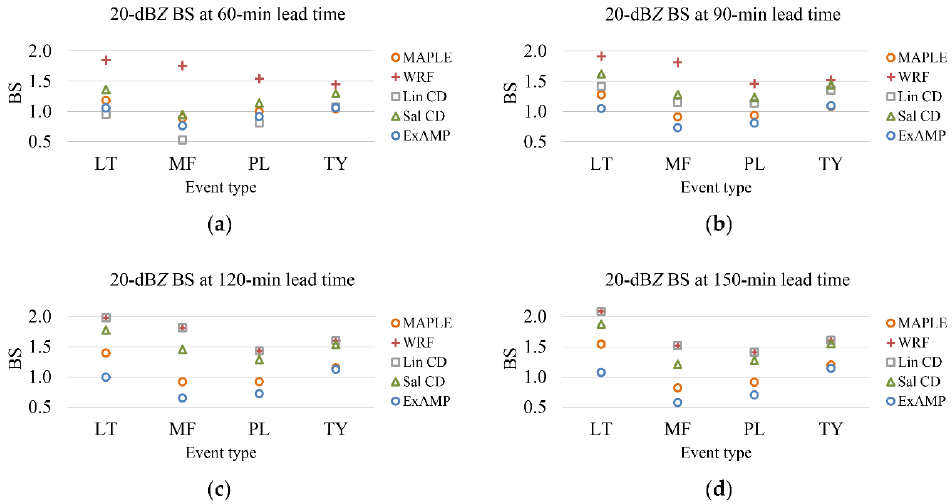
Figure 9. The BSs of MAPLE, WRF, Lin CD, Sal CD, and ExAMP for the LT, MF, PL, and TY event types above the 20 dB Z threshold at the lead times of ( a ) 60, ( b ) 90, ( c ) 120, and ( d ) 150 min, computed over the grid points with observed reflectivity exceeding 0 dB Z .